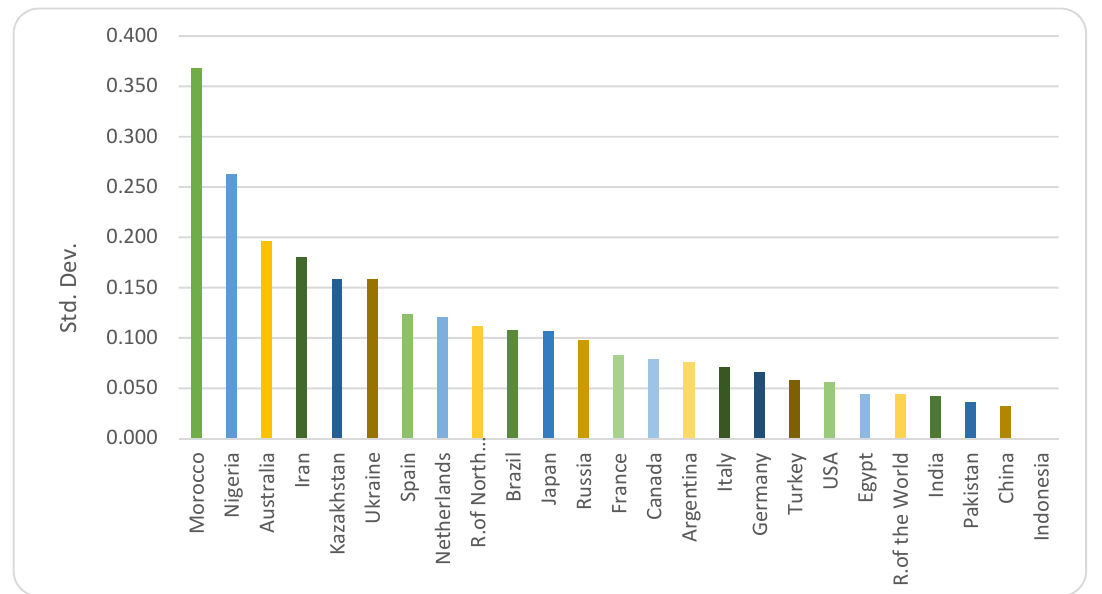
Table 1. Regional, sectoral and factor aggregations in the model. Regions Sectors Factors of Production